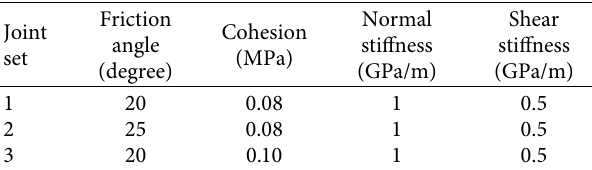
Table 3: Physical and mechanical parameters of